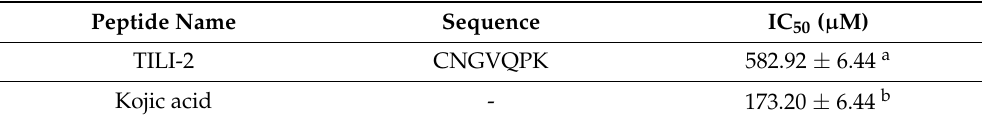
Table 1. The half-maximal monophenolase inhibitory concentration (IC 50 ) of TILI-2 against monophe- nolase activity of tyrosinase.